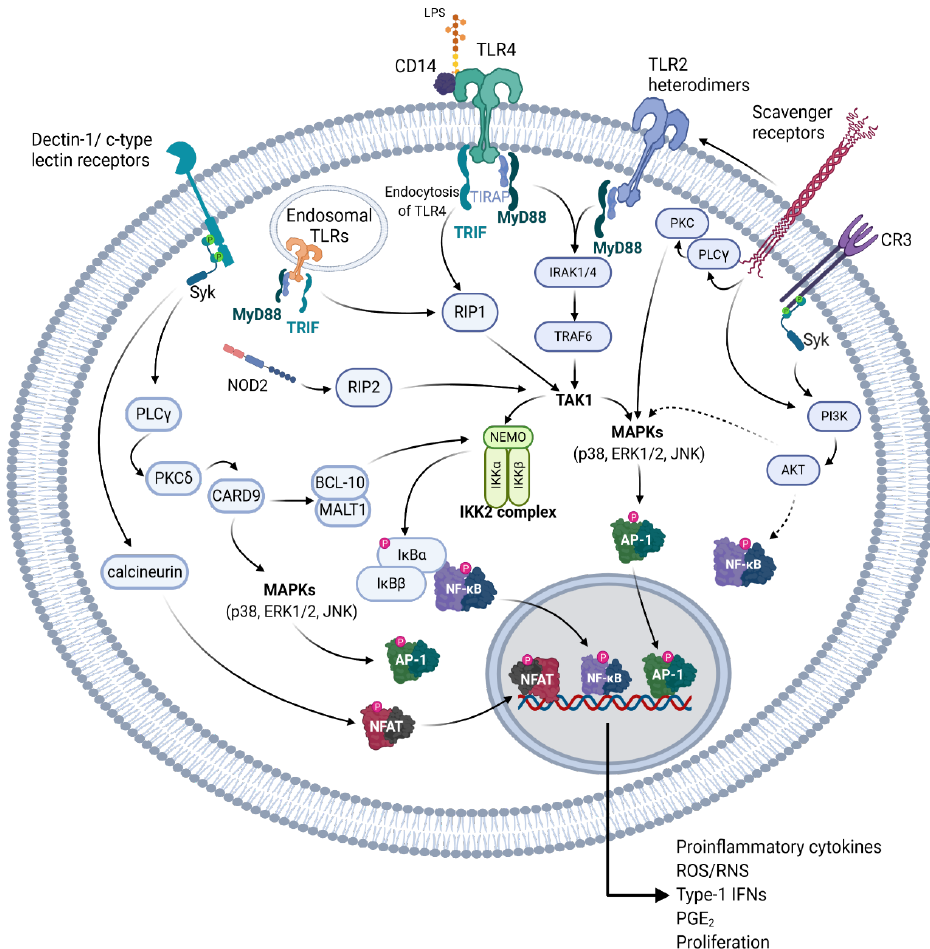
Figure 3. Receptors that potentially bind to NAG polysaccharides and the respective signal transduction pathways initiated. A graphical representation depicting various pattern recognition receptors (PRR) of the innate immune system, which have been shown to recognize various structural components of NAG polysaccharides, or similar polysaccharides of other plants. Solid arrows indicate a probable direct activation, dotted arrows indicate unknown intermediate steps. These pathways are detailed in Section 5.1. Created with BioRender.com.